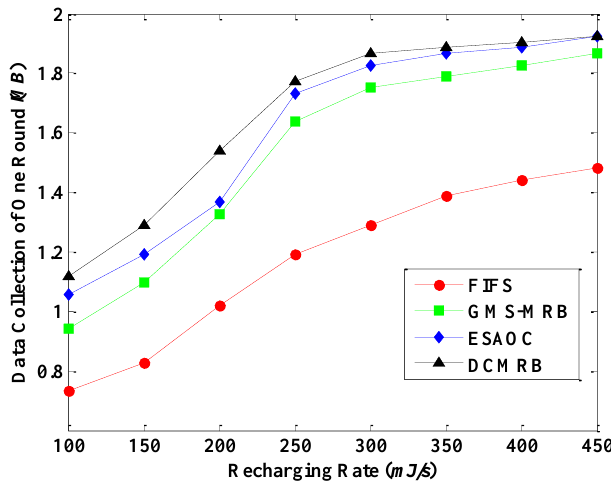
Figure 28 . The amount of the collected data under different recharging rates.